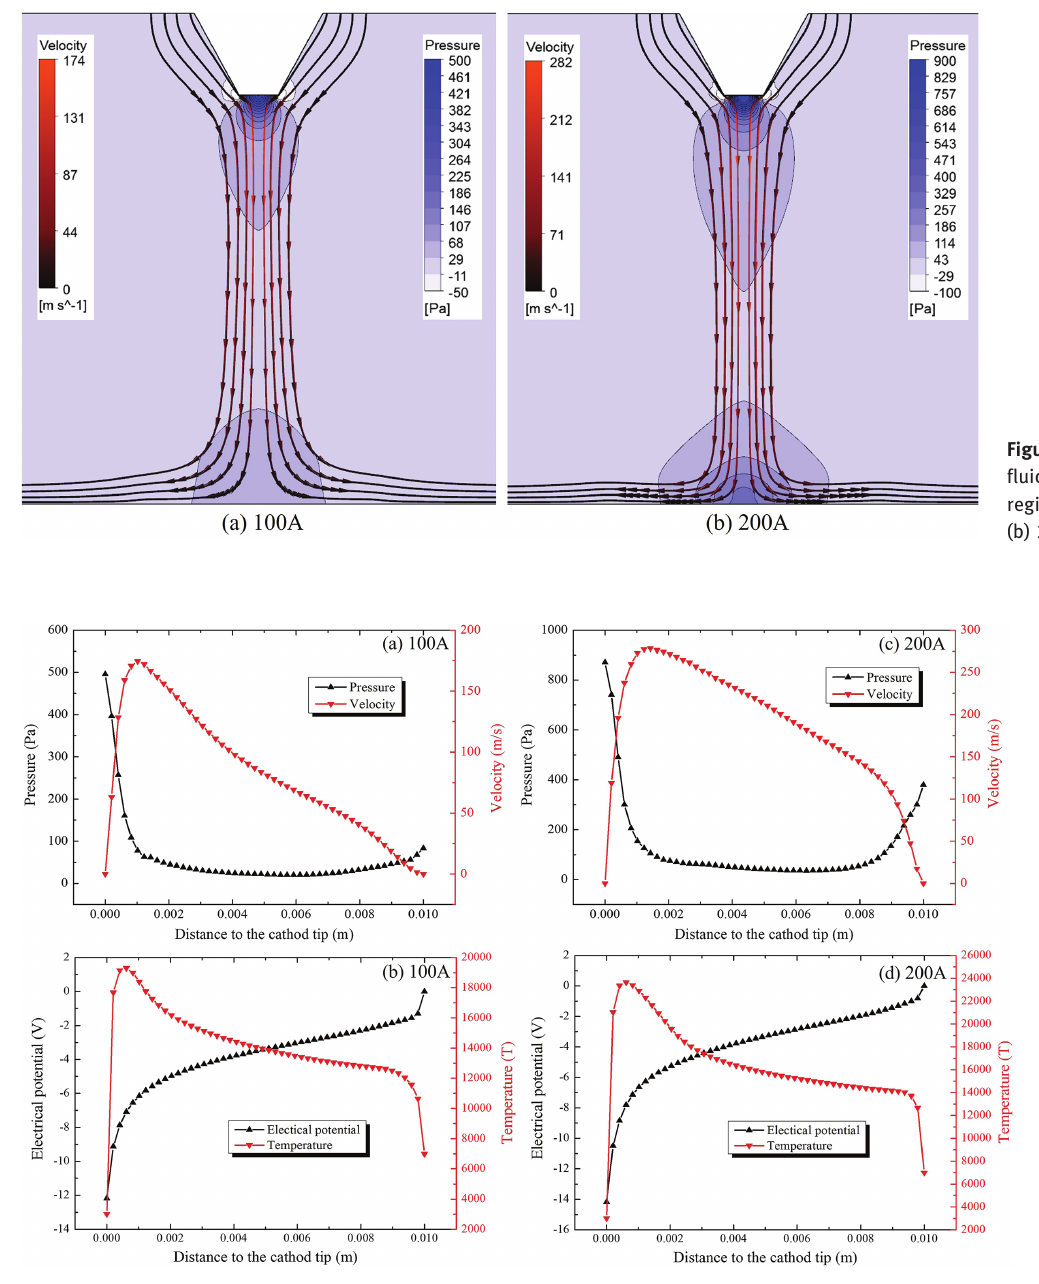
Figure 6: Variation of pressure, velocity, electrical potential and temperature along the axis of arc region.